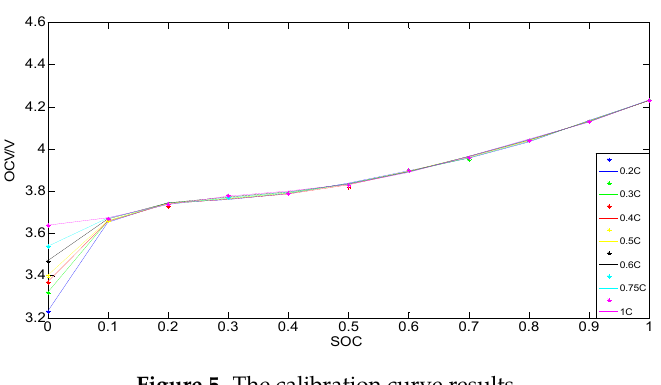
Figure 5. The calibration curve results.